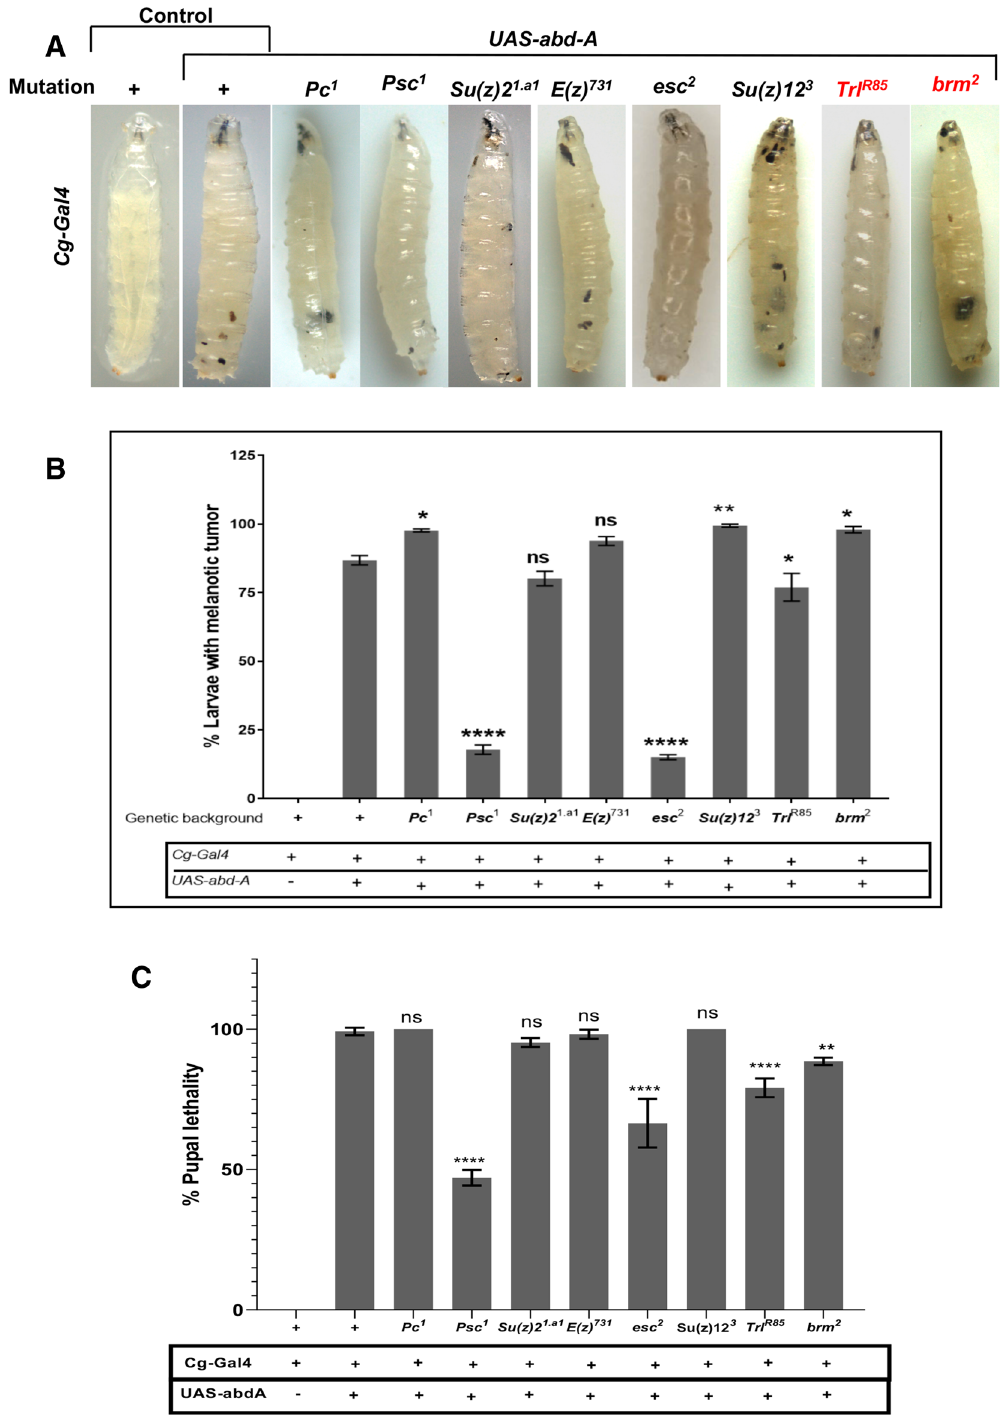
Figure 5. Effect of PcG and trxG mutations on the abd-A induced tumor phenotype. ( A ) Effect of PcG and trxG on subcutaneous melanotic tumor formation. (trxG members have been highlighted in red in 5A) Over-expression of abd-A gene is driven by Cg-Gal4. Most of PcG and trxG mutants have effect on the phenotype. Polycomb mutants, esc 2 (PRC2 member) and Psc 1 (PRC1 member) show a decrease in severity of phenotype (size and numbers of melanotic body). Su(z)12 3 and Pc 1 have increased severity. Brm 2 , Trl R85 , Su(z)2 1.a1 and E(z) 731 do not show any change in severity compare to Cg-Gal4 driven abd-A over-expressed individual. ( B ) Comparative quantification of melanotic tumor formation phenotype in abd-A over-expressed (driven by Cg-Gal4) individual in different PcG and trxG background. Percentage of tumor showing individuals is plotted on Y-axis (no. of animal screened is > 80 in each case, error bars represent the standard error). Phenotype is rescued in esc 2 ( p < 0.0001) , Psc 1 ( p < 0.0001), and Trl R85 ( p = 0.0223) mutants while Pc 1 ( p = 0.0109), Su(z)12 3 ( p = 0.0028) and Brm 2 ( p = 0.0088) have a significant increase in melanotic tumor formation. ( C ) Percent pupal lethality in PcG and trxG mutant background. Psc 1 ( p < 0.0001), esc 2 ( p < 0.0001), brm 2 ( p = 0.0042) and Trl R85 ( p < 0.0001) show decrease in pupal lethality. ( D ) Number of PH3 positive larvae in mutant backgrounds, Compared to Cg-Gal4 overexpression of abd-A alone, the overexpression did not significantly alter the number of PH3+ hemocytes in Pc 1 ( p = 0.2554) , Psc 1 ( p = 0.1275) , E(Z) 731 ( p = 0.7907) , esc 2 ( p = 0.3282), Su(z)12 3 ( p = 0.8642) , and Trl R85 ( p = 0.8975)